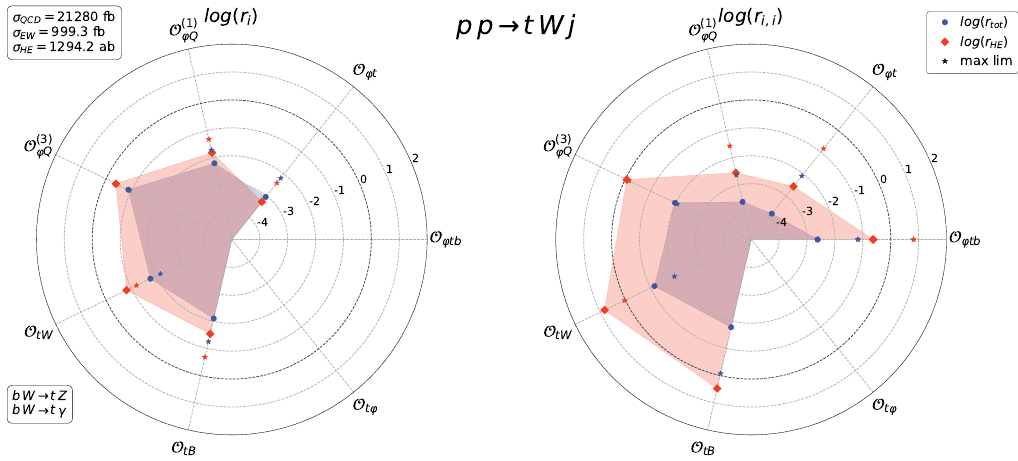
Figure 7. Radar plot for the p p t W j process at the 13 TeV LHC. The left and right (cid:12)gures ! show the impact of each operator, for a Wilson coe(cid:14)cient of 1 TeV (cid:0) 2 , at linear (absolute value of SM-EFT interference) and quadratic (EFT amplitude squared) level in each Wilson coe(cid:14)cient, relative to the SM EW contribution, (cid:27) . The inclusive QCD-induced cross section, (cid:27) , is EW QCD also shown. The relative impacts at inclusive level and in a high energy region of phase space are depicted by the blue and red dots, respectively (see main text). The stars denote the corresponding prediction when saturating the individual limits on the coe(cid:14)cients summarised in table